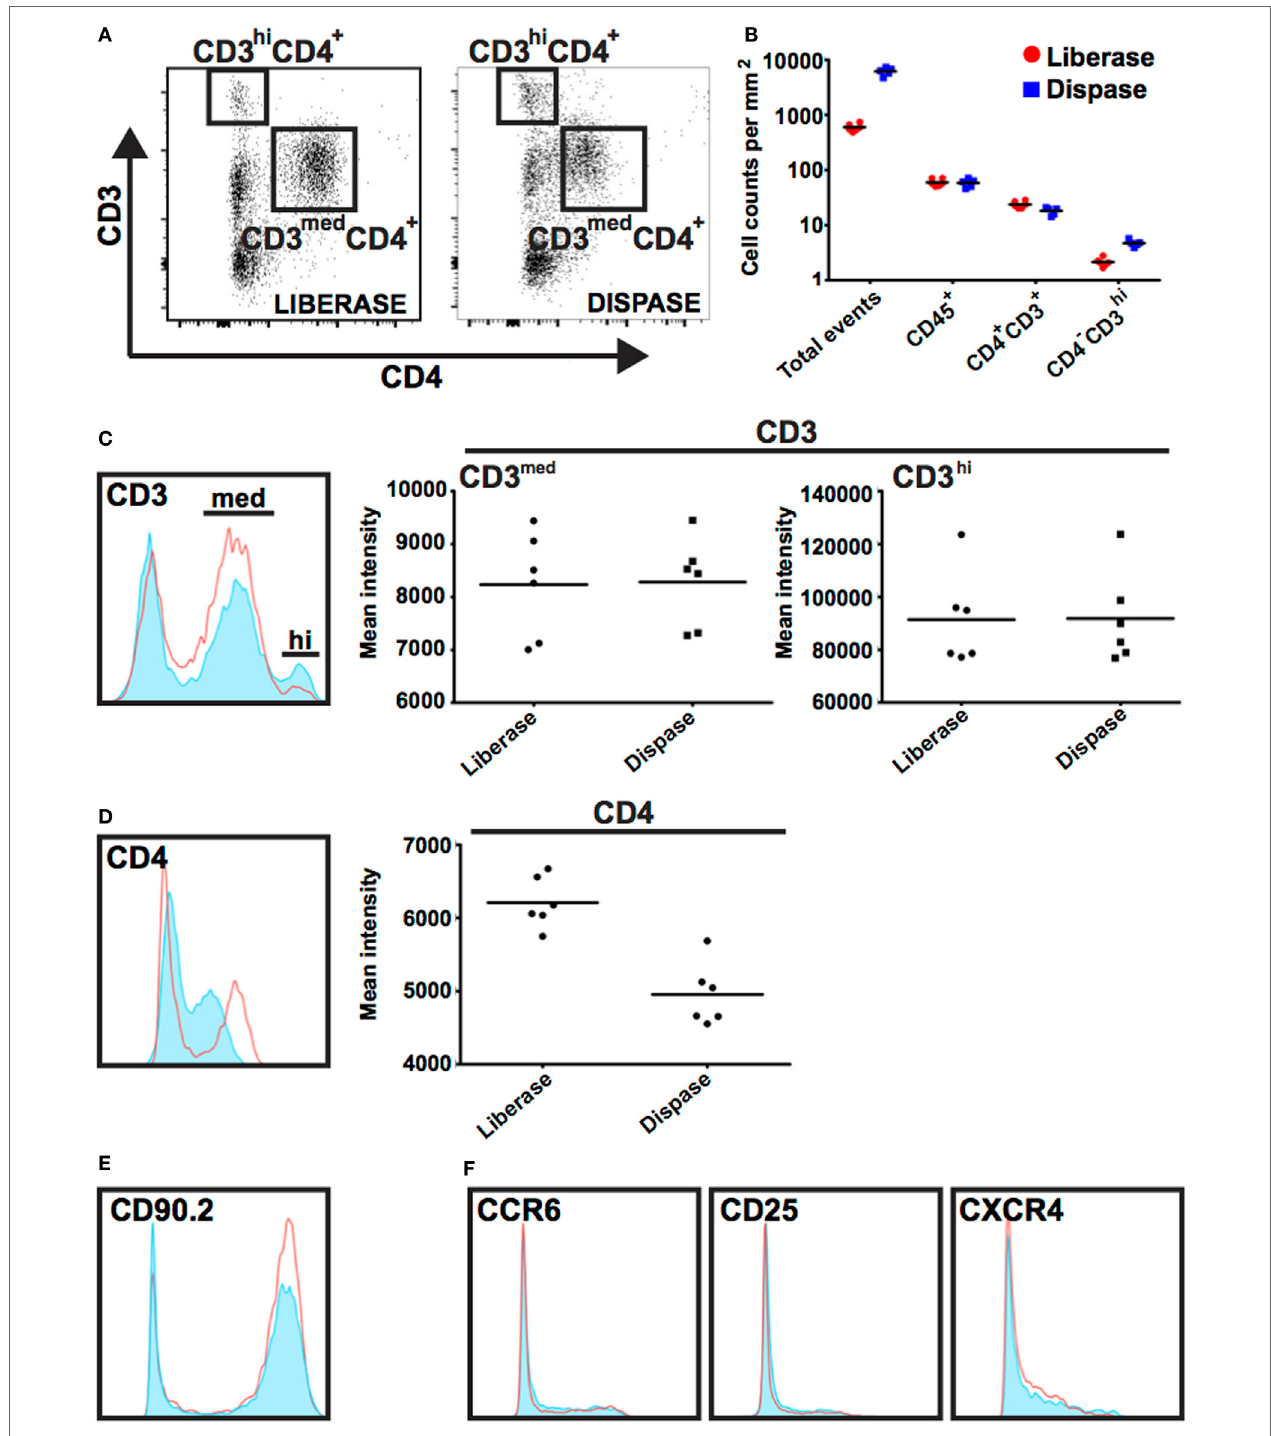
FIgURe 5 | Impact of Dispase and Liberase/Collagenase D digestion methods on populations of immune cells. (A) Single-cell suspensions were prepared using Liberase TL/Collagenase D (Liberase) or Dispase enzyme cocktails and isolated cells co-stained with antibodies prior to analysis by flow cytometry. Cells were initially gated based on CD45 expression and subsequently gated on CD3 and CD4 expression as shown. CD3 hi CD4 − expression marks dendritic epidermal T cells (DETCs) located in mouse epidermis and CD3 + CD4 + expression is detected on dermal infiltrating T cells. (B) Graph representing the number of events as counted by flow cytometry in a 1 mm 2 area of wound tissue. Note tissue digestion using Dispase leads to an approximate 10-fold increase in total cell numbers; however, the number of CD45 + immune cells was similar regardless of digestion method. (C–F) Histograms show expression of cell surface markers in gated Dispase II digestion (red line) and Liberase TL/Collagenase D digestion (filled light blue) populations. With the exception of CD4, there was no detectable difference in intensity of surface marker